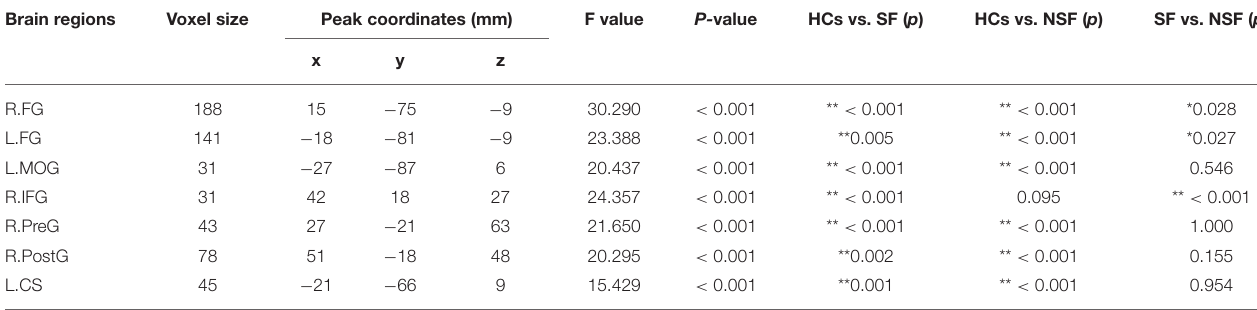
TABLE 2 | One-way ANOVA and pairwise comparison of ALFF among the three groups. Brain regions Voxel size Peak coordinates (mm) F value P- value HCs vs. SF ( p ) HCs vs. NSF ( p ) SF vs. NSF ( p ) x y z 188 15 − 75 − 9 30.290 < 0.001 ** < 0.001 ** < 0.001 *0.028